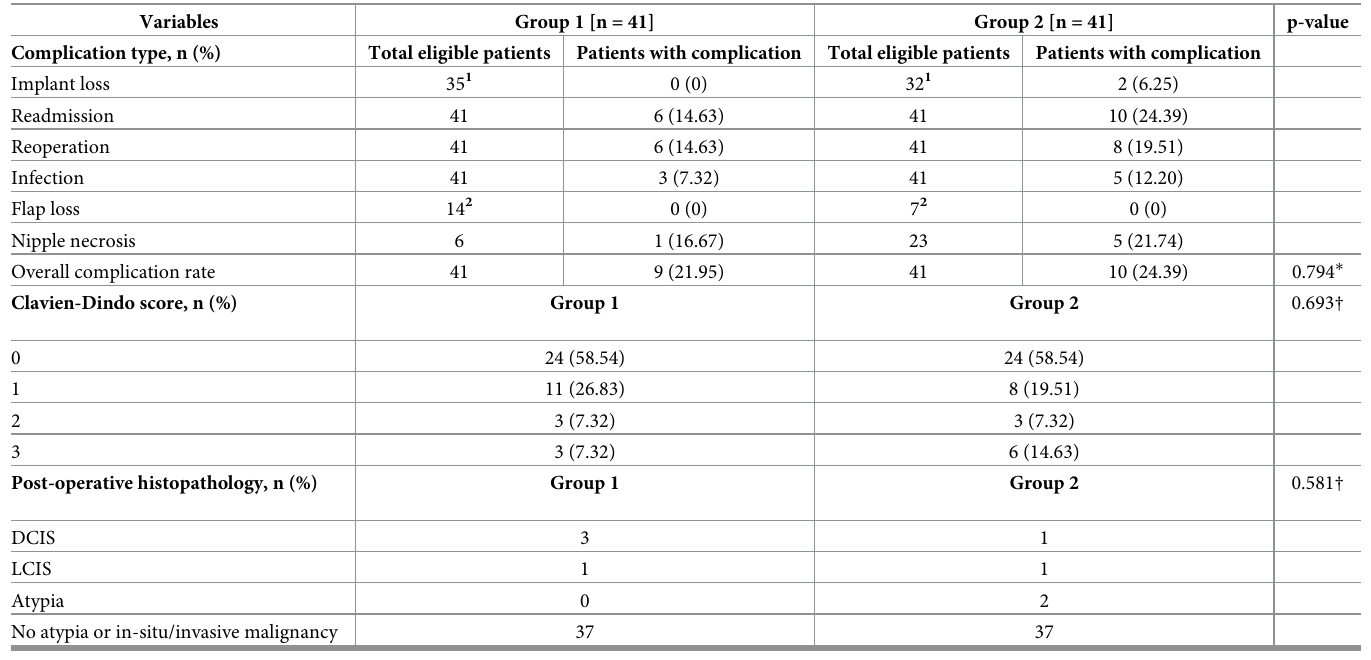
Table 4. Summary of post-operative characteristics including post-operative complications, Clavien-Dindo score, and post-operative histopathology.